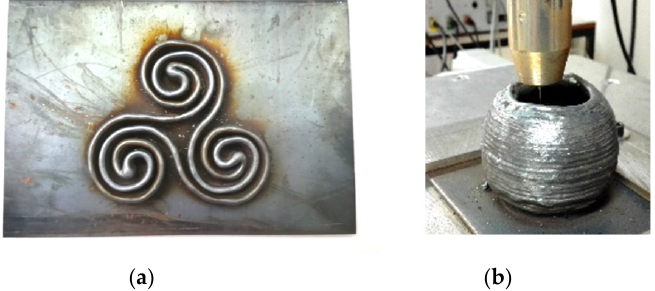
Figure 2. Examples of geometries obtained by WAAM: ( a ) Piece obtained by continuous trajectory and complex geometry in x-y direction; ( b ) Piece obtained by continuous trajectory and growing geometry in z direction.